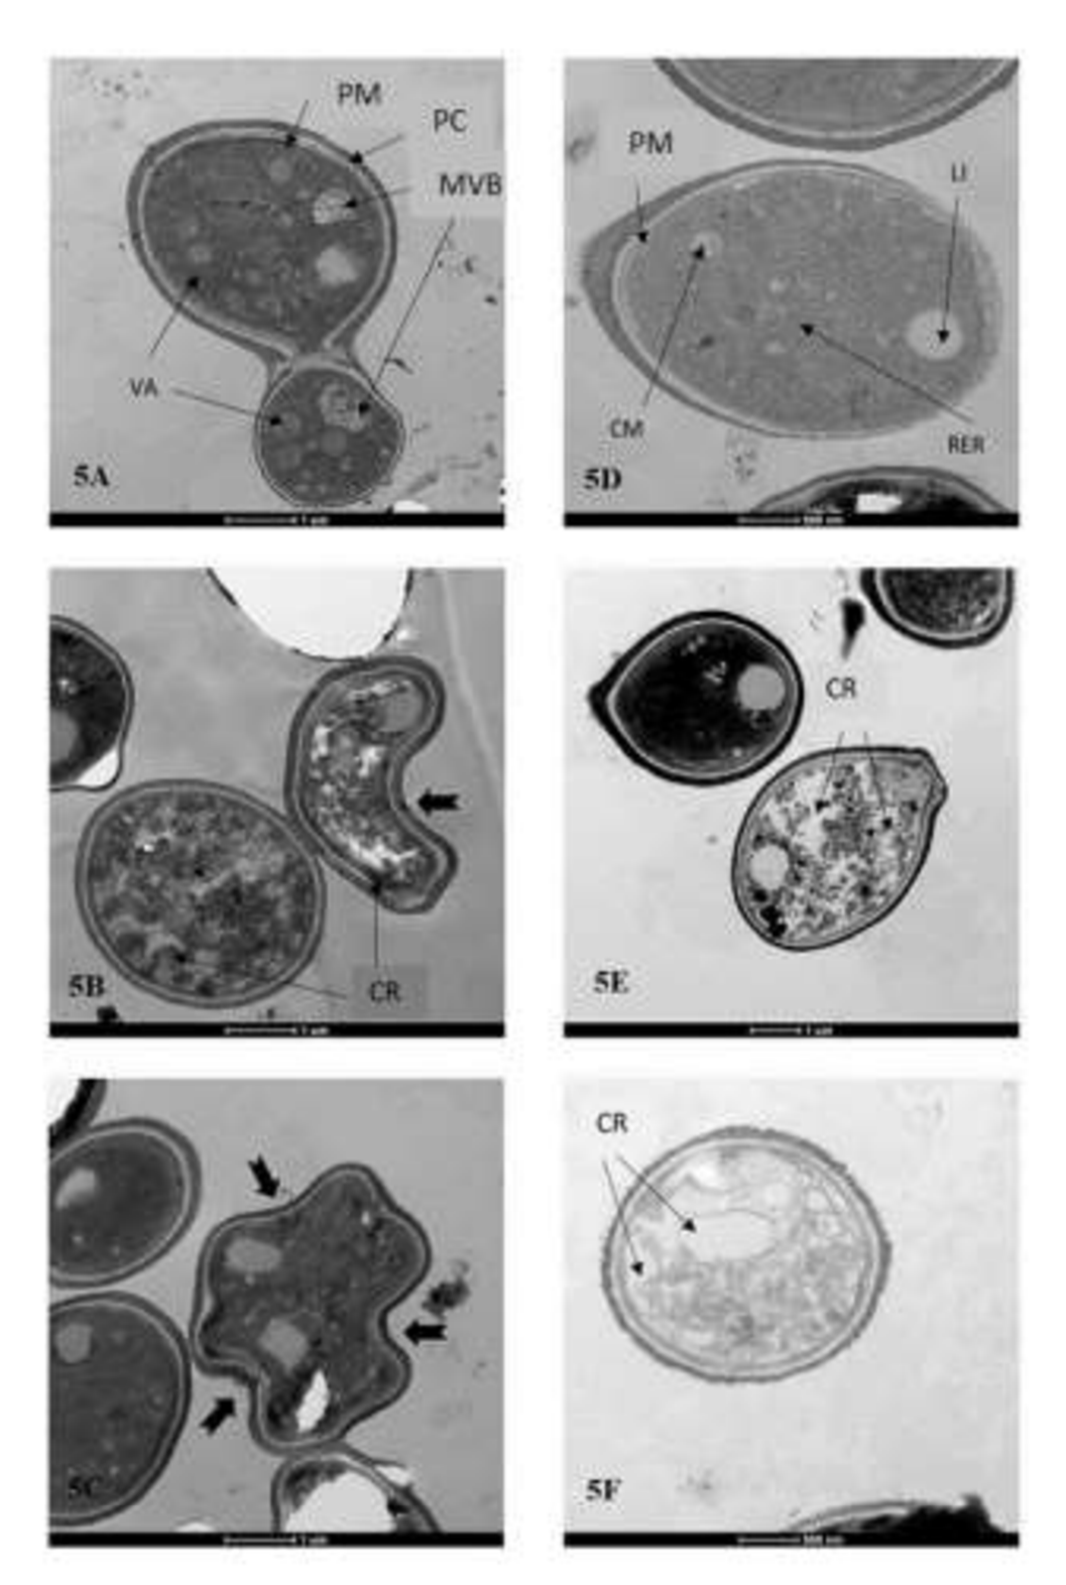
Figure 5. Transmission electron microscopy of Cryptococcus neoformans and Cryptococcus gattii species complexes. (A) Untreated Cryptococcus neoformans species complex cells. (B, C) Liriodenine-treated Cryptococcus neoformans species complex cells at a concentration of 31.25 µg.mL -1 . (D) Untreated Cryptococcus gattii species complex cells. (E, F) Liriodenine-treated Cryptococcus gattii species complex cells at a concentration of 62.5 µg.mL -1 . PM: plasma membrane; PC: polysaccharide capsule; MVB: multivesicular bodies; VA: vacuoles; LI: lipids; RER: rough endoplasmic reticulum; CR: cytoplasmic rarefaction; cell membrane